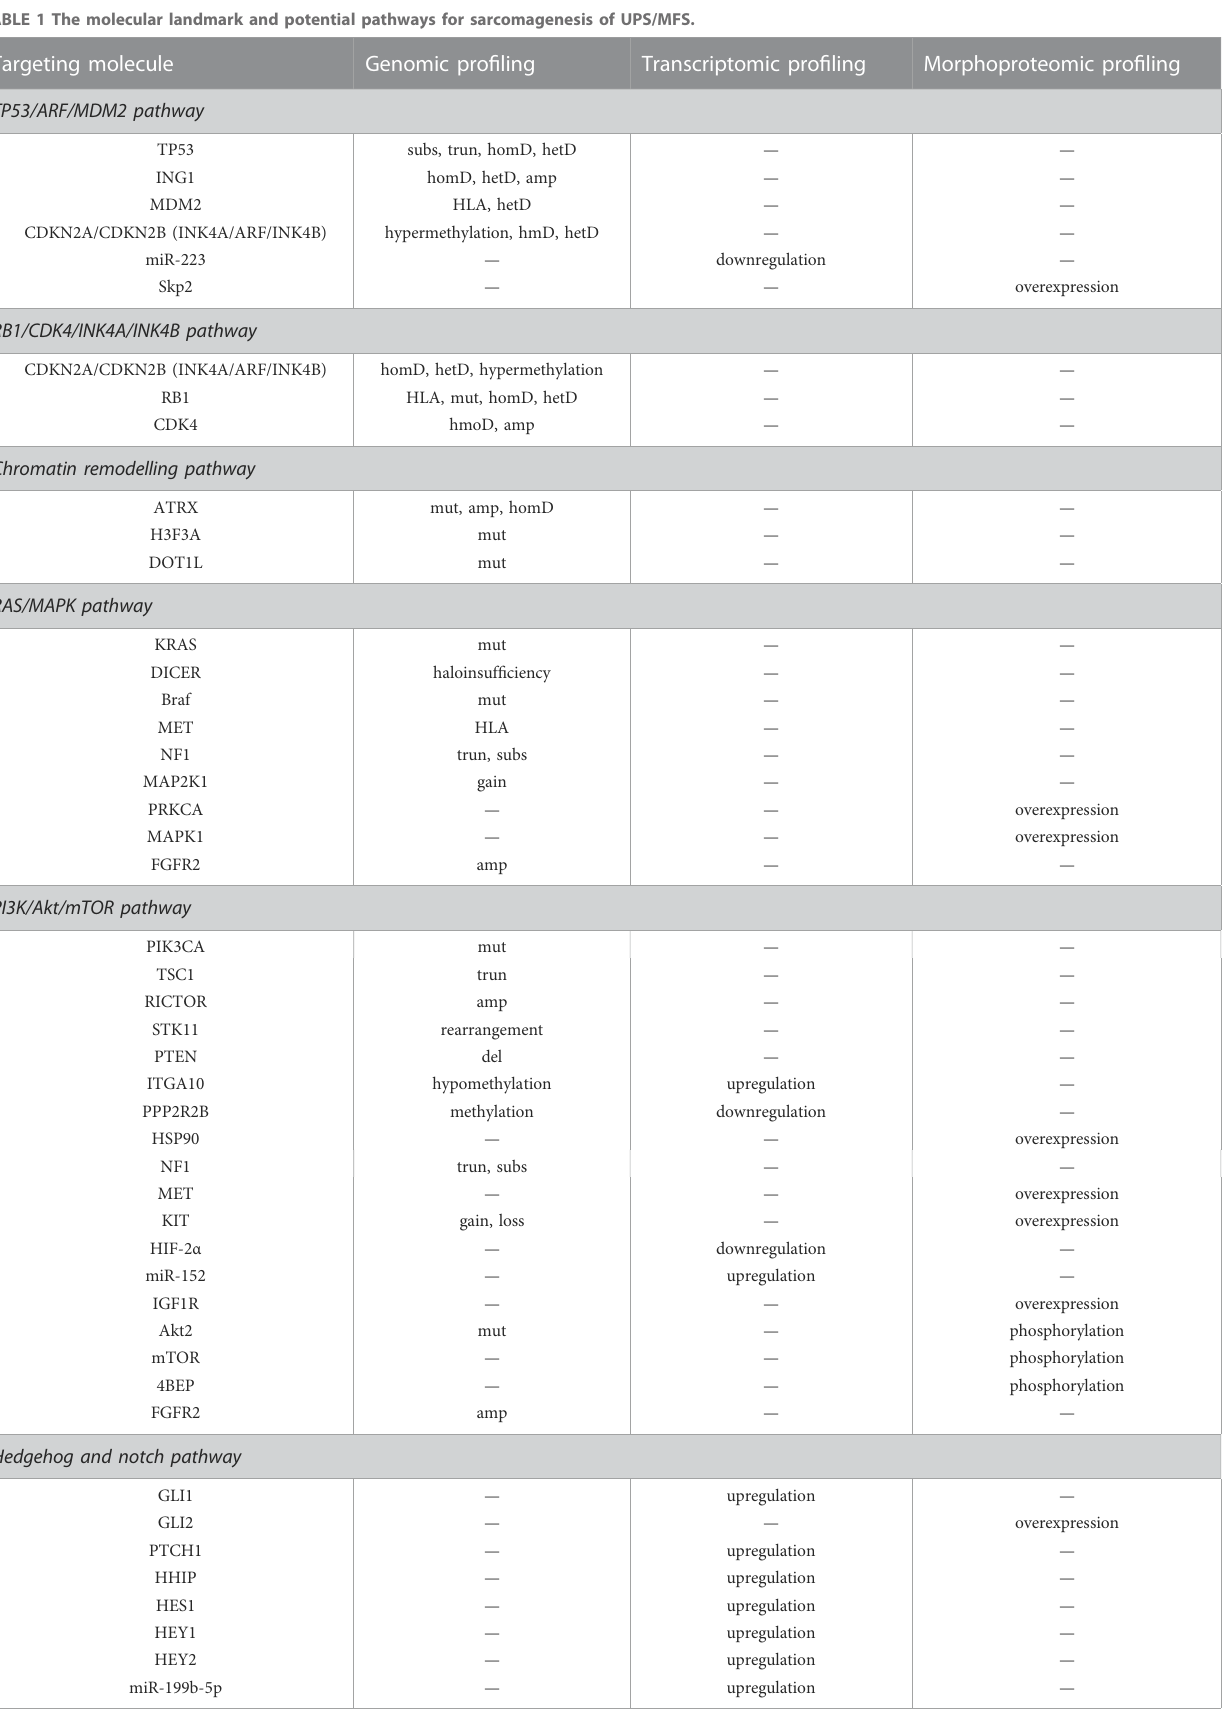
TABLE 1 The molecular landmark and potential pathways for sarcomagenesis of UPS/MFS. Targeting molecule